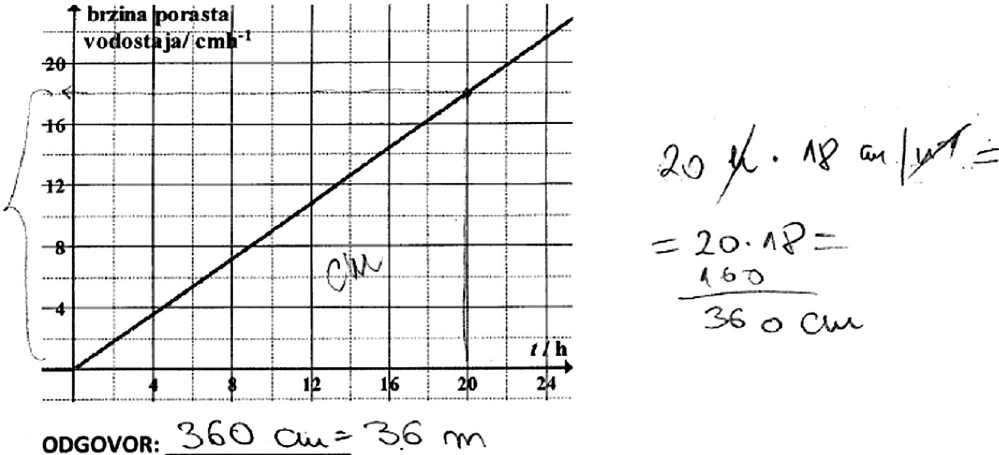
s.FIG. 4. The response of one student to question CA1, indicating dimensional analysis which led student to the idea of multiplication. The variables on the axes of the graph are time and water level rate of